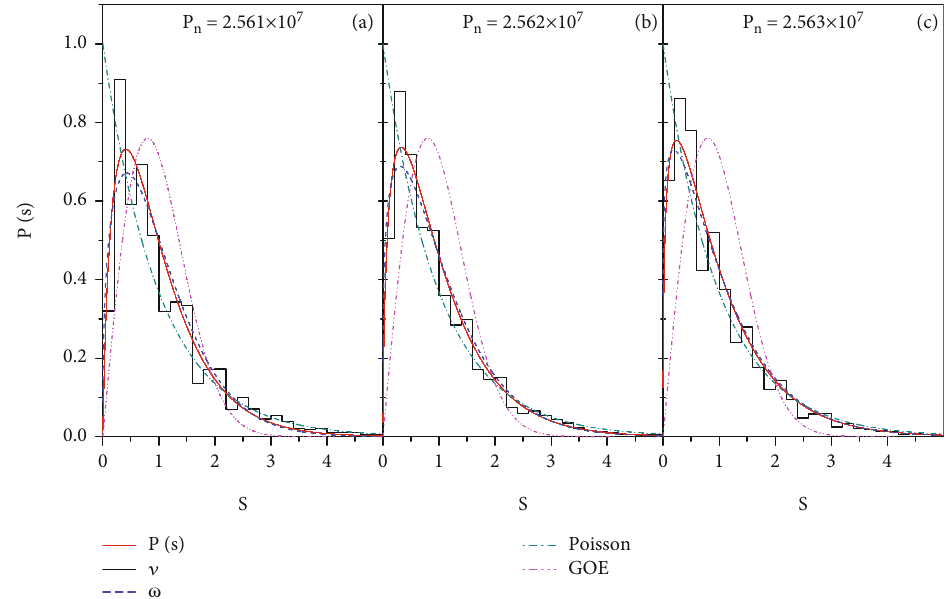
Figure 5: Nearest Neighbor Spacing Distribution (NNSD) for 10 4 primes at (a) 25.61 million, (b) 25.62 million, and (c) 25.63 million, with the best fi t calculated using the inverse χ 2 distribution Equation (3) and the Brody distribution Equation (7). For reason of comparison the Poisson and GOE curves are also included.